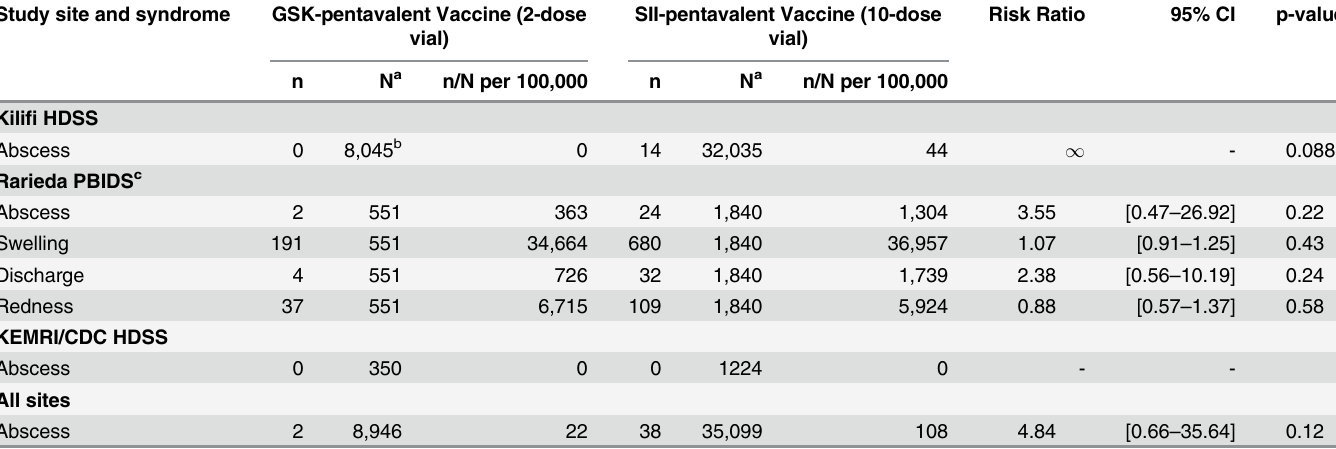
Table 5. Risk of developing abscess or similar symptoms within 7 days in relation to SII-pentavalent vaccine injection or GSK-pentavalent vaccine injection in VAEIK study sites, Kenya, 14 February 2011 – 13 February 2013. Study site and syndrome GSK-pentavalent Vaccine (2-dose